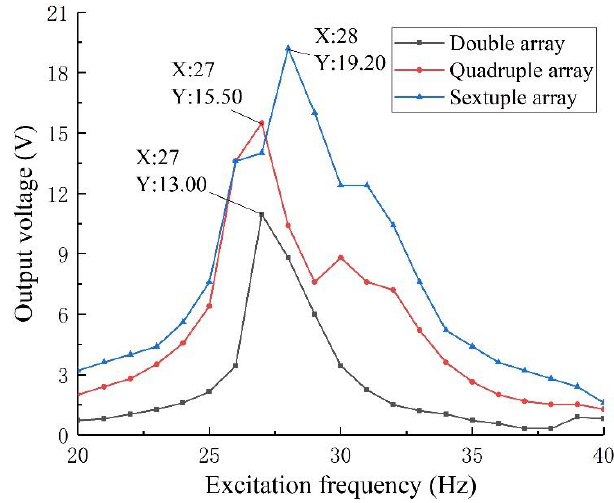
Figure 20. Output voltage of array structure.